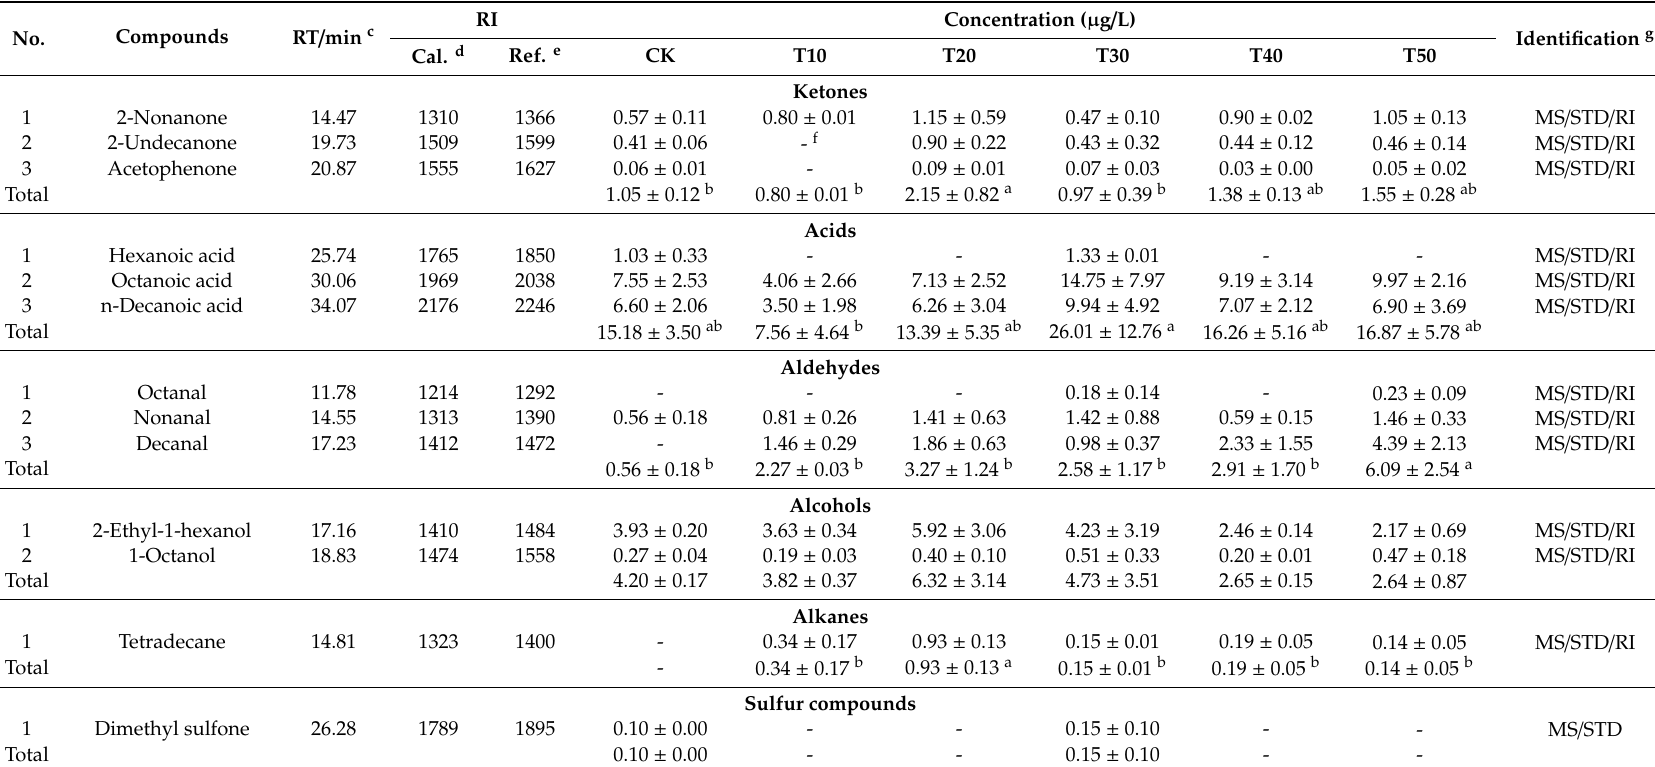
Table 3. Volatile compounds in the skim milks of di ff erent preheat time identified by